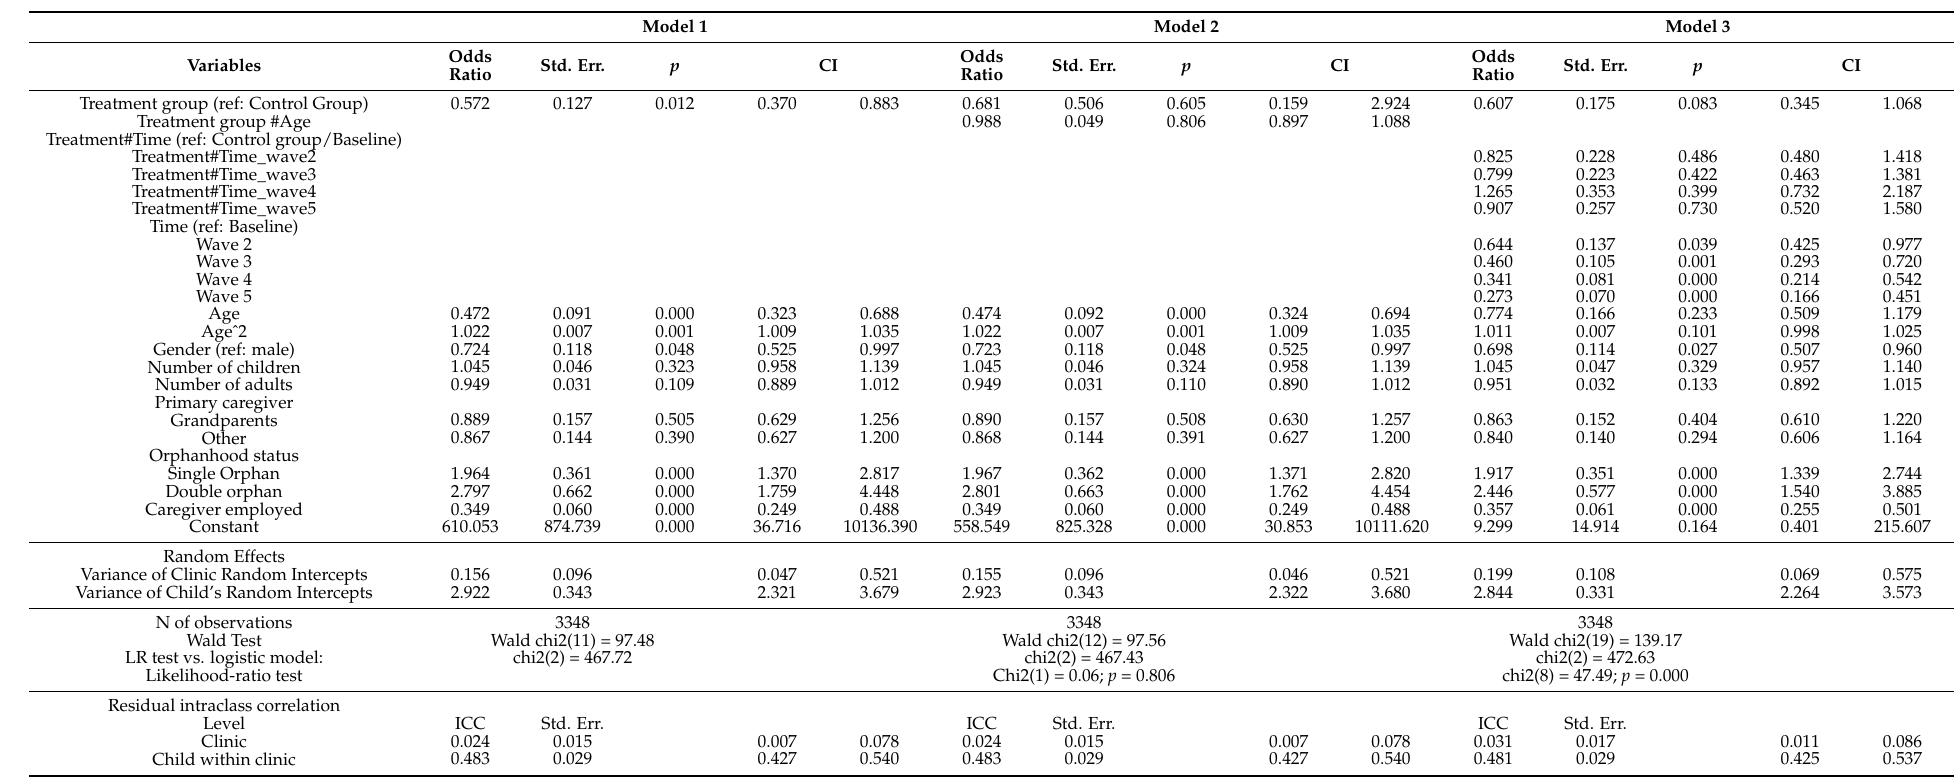
Table 4. Multilevel mixed-effects logistic regression